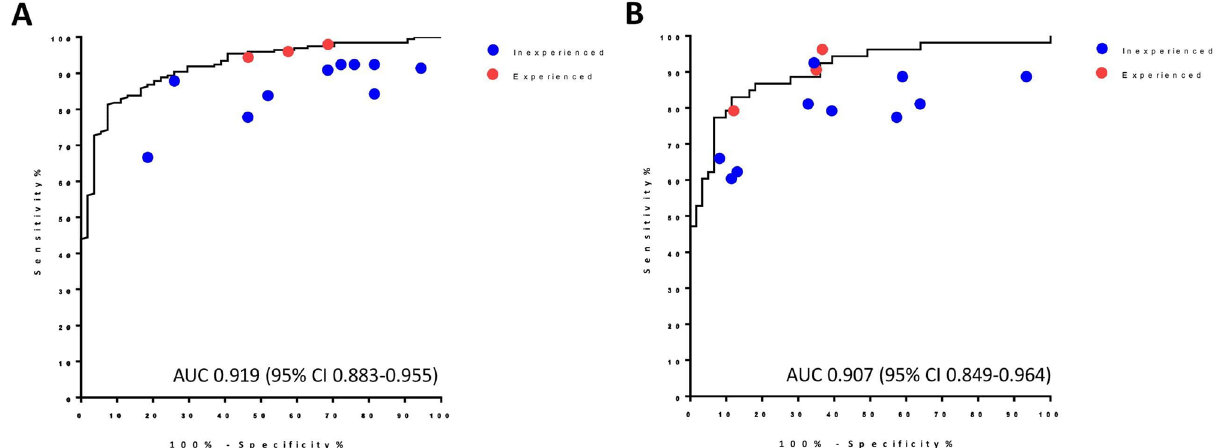
Figure 2. Diagnostic performance of CAD and physicians for cPTC according to nodule size. The ROC curves and AUC of CAD for cPTC are presented for thyroid nodule with ( A ) a size < 2 cm, and ( B ) a size ≥ 2 cm. Dots on each graph indicate the diagnostic performance (sensitivity and specificity) of the individual physicians in the inexperienced (blue), and experienced (red) groups. CAD, computer-aided diagnosis; ROC, receiver